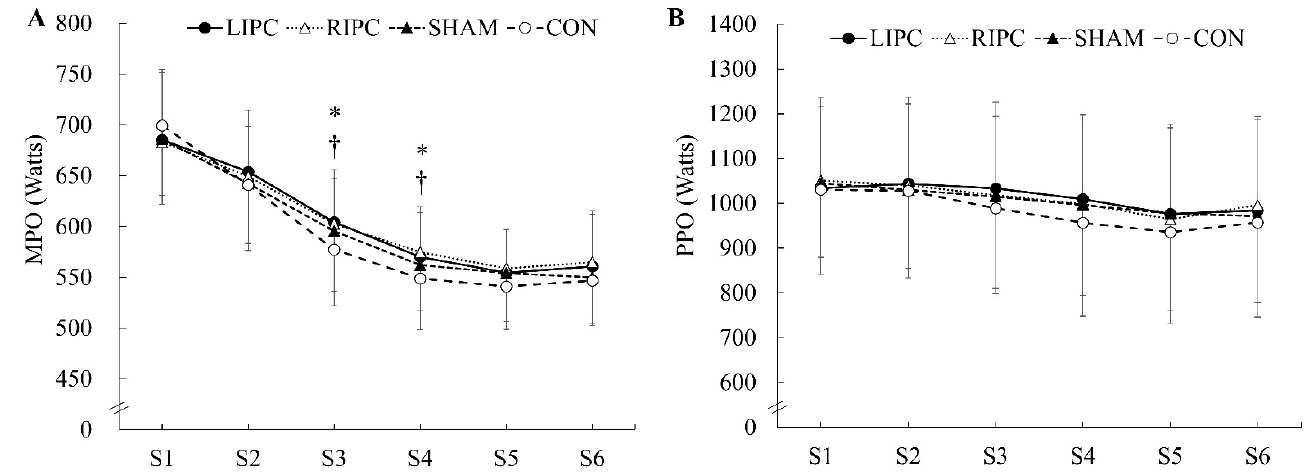
Figure 2. Effects of local (LIPC) and remote (RIPC) ischemic preconditioning on ( A ) mean power outputs (MPO) and ( B ) peak power outputs (PPO) during a sprint interval exercise (SIE) test. * p < 0.05, significant differences between LIPC and control (CON); † p < 0.05, significant differences between RIPC and CON; S1–S6, sprint 1–6.